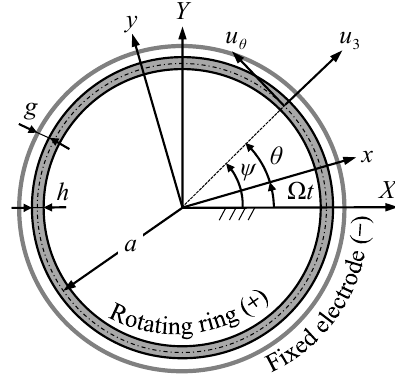
Figure 1. A flexural rotating ring surrounded by a circular fixed electrode, a uniformly distributed electrical field along the radial direction is made by applying an electrical potential difference between the ring and fixed electrode.